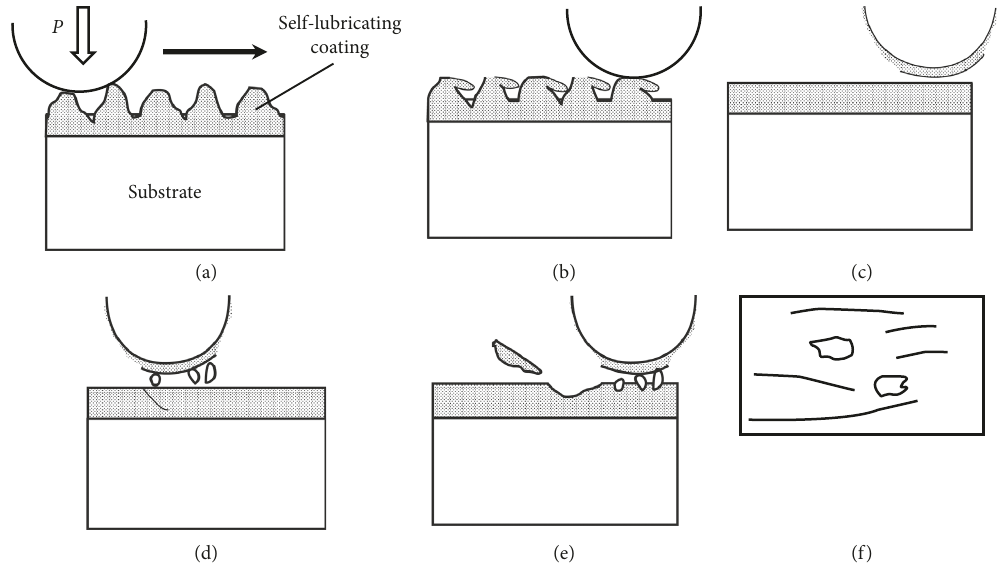
Figure 15: Schematic of wear surface